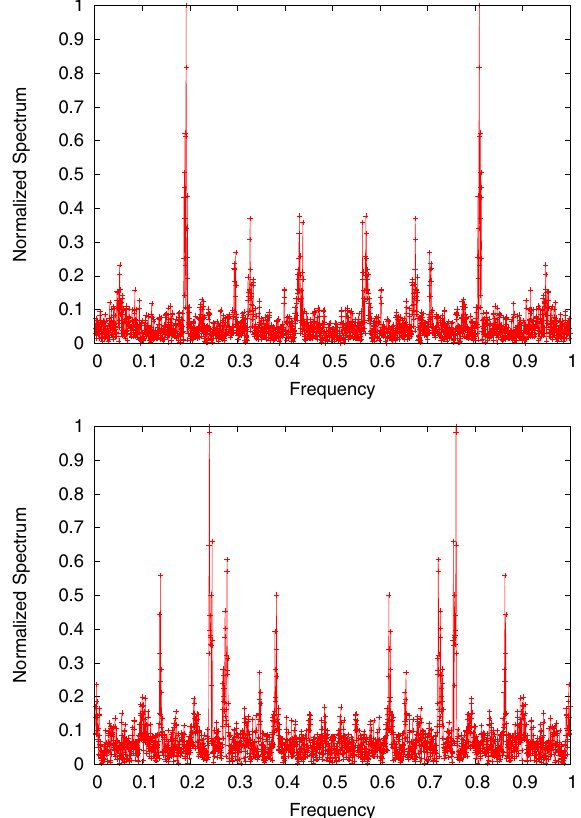
FIG. 5. Spectrum analysis of the electric field in x -direction (top) and y -direction (bottom) at x ¼ y ¼ 0 . For this analysis, the beam is tracked in a constant focusing channel with tune Q 0 . 19 and Q 0 . 24 . Peaks occur at the tune frequencies, while a y ¼ coupling of both planes excites many other smaller local